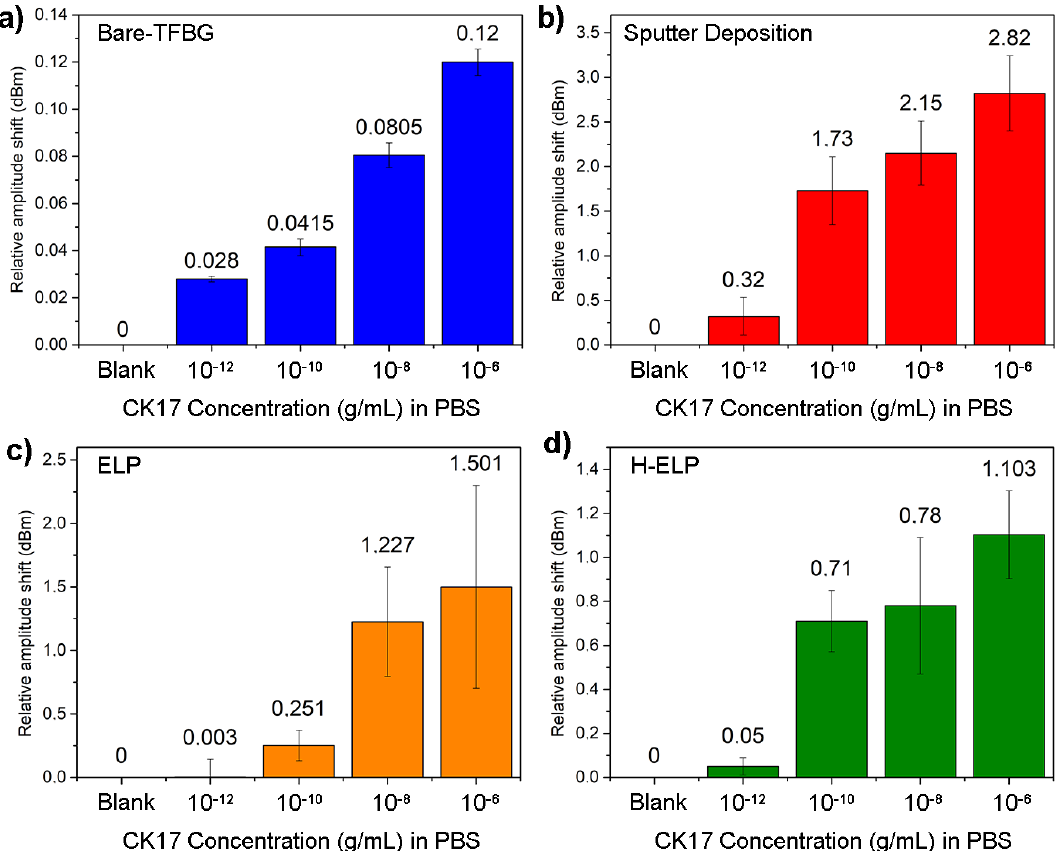
Figure 7. Cytokeratin-17 detection in Phosphate Buffer Saline (PBS). ( a ) Detection using the sensitivity of the cut-off area of bare-TFBGs. ( b ) Detection through the SPR-related modes of gold sputter-coated TFBGs. ( c ) Detection through the sensitive modes of the polarization dependent loss (PDL) spectra of gold-ELP-TFBGs. ( d ) Detection through the hybrid configuration. Data show means of amplitude shifts ± standard deviations for three tested fibers, in each condition.